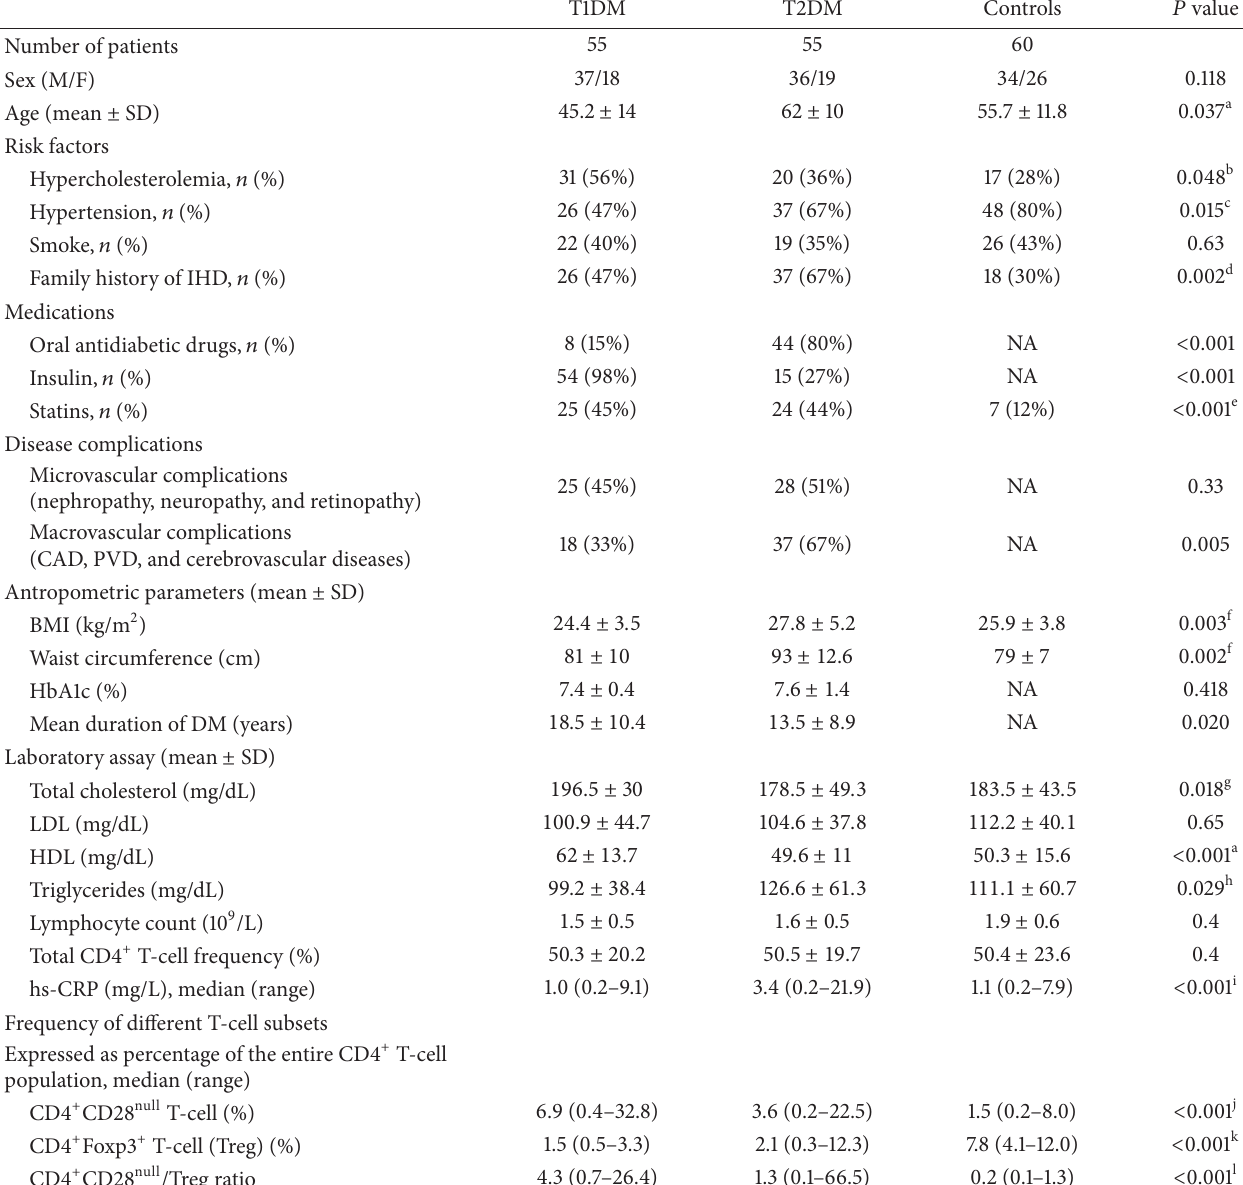
Table 1: Clinical characteristics of study